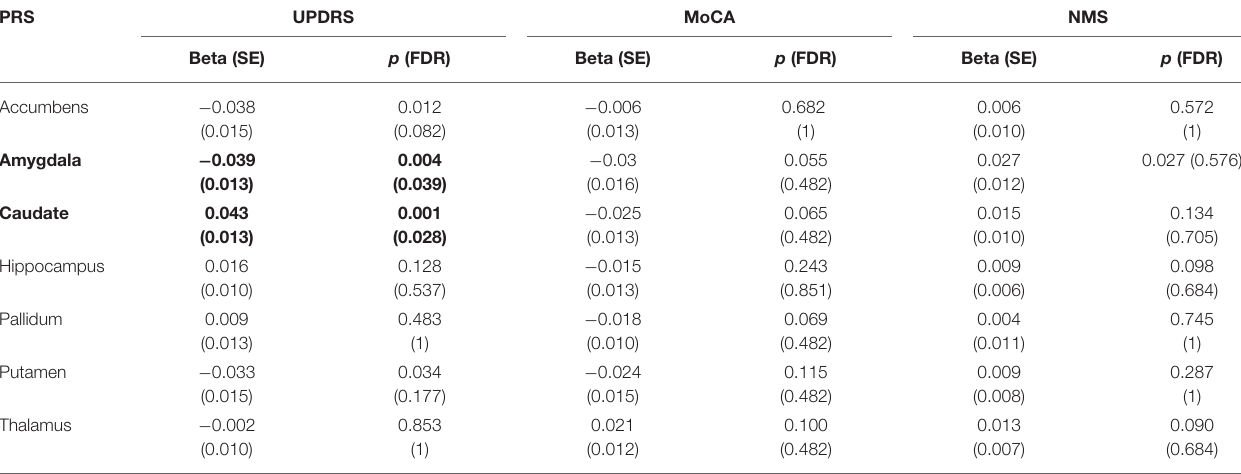
TABLE 3 | Results of multivariable regression models testing associations of PD endophenotypes with best-fit Polygenic Risk Scores (PRSs) for subcortical volumes in the Neuromed